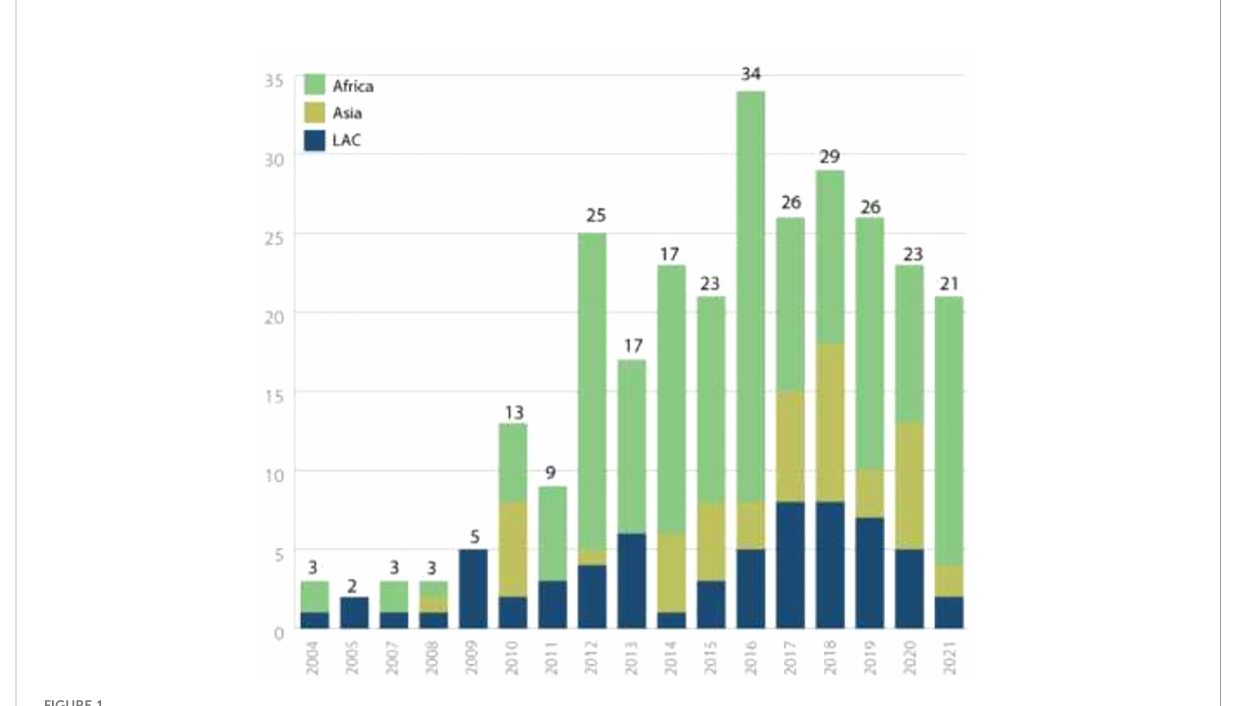
FIGURE 1 Bioforti fi ed crop varieties are released by year and